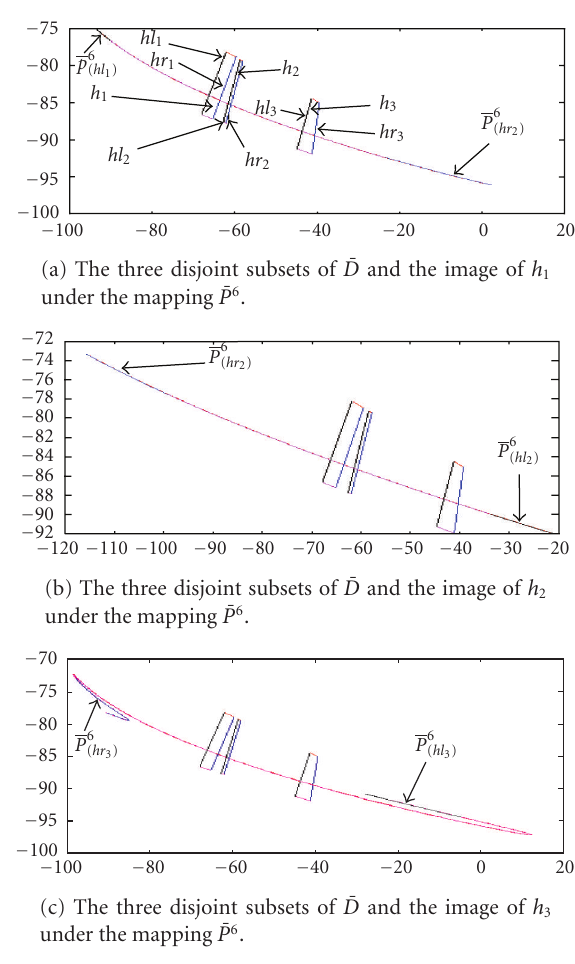
Figure 4.4. The three disjoint subsets of ¯ D and their image under the mapping ¯ P 6 .